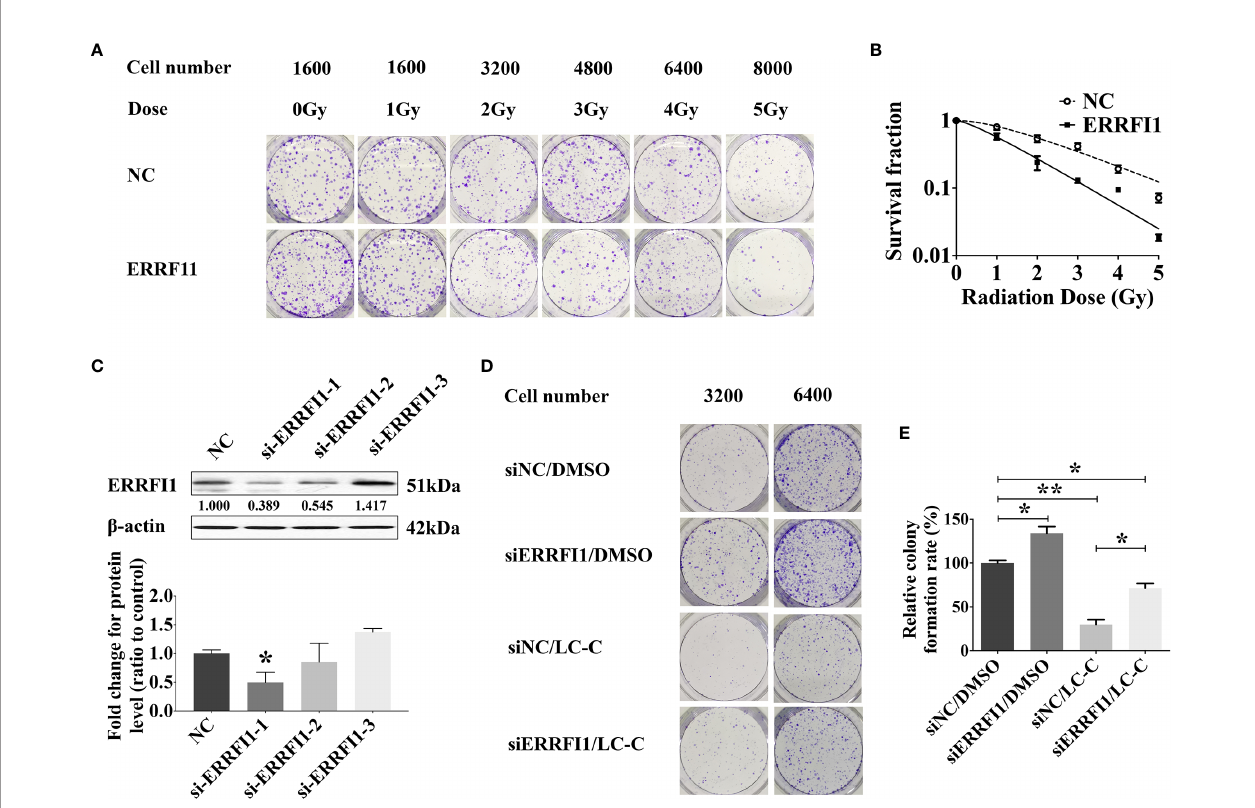
FIGURE 4 | ERRFI1 expression regulates LC-C-enhanced radiosensitivity of A549-IR cells. (A) Representative images of colony formation assays in A549-IR cells with/without overexpression of ERRFI1. (B) Clonogenic cell survival curves showing the decrease of clonogenic survival in the ERRFI1 overexpressed cells; (C) Western blotting showing the ERRFI1 expression after siRNA-ERRFI1 transfection in A549-IR cells, and ERRFI1-1 was used in the subsequent colony formation assays; (D) Representative images of colony formation showing the knocking-down of ERRFI1 in A549-IR cells on the radiosensitization effects of LC-C. (E) Diagram of clonogenic cell survival rate showing the knocking-down of ERRFI1 in A549-IR cells attenuated radiosensitization effects of LC-C in A549-IR cells. Results shown are the means ± standard deviation. *Signi fi cant difference at P < 0.05 level. **Signi fi cant difference at P < 0.01